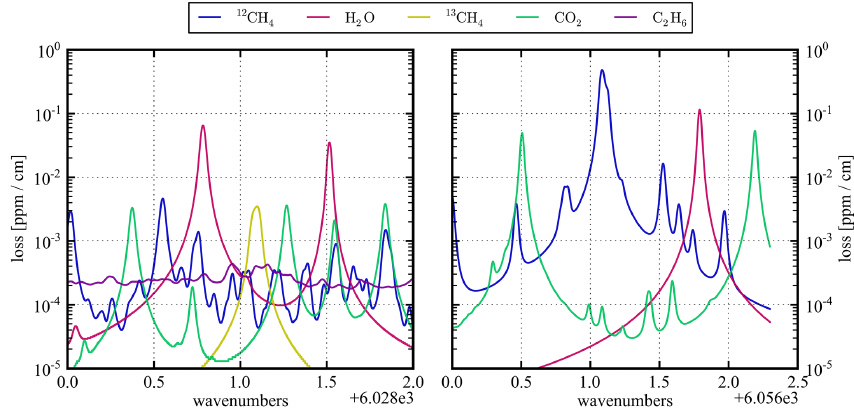
Figure 1. Spectra of key species in the frequency ranges employed in the spectrometer, displaying loss on a log scale vs. optical frequency in wavenumbers for the low-frequency region (left panel) and high-frequency region (right panel). The spectra for methane (both isotopologues, concentration of 2ppm), water vapor (1%), and carbon dioxide (400ppm) are obtained from the HITRAN spectral database (Rothman et al., 2013), for a pressure of 148Torr and T = 45 ◦ C. The ethane spectrum (for a concentration of 1ppm) was obtained experimentally using CRDS from a 400ppm